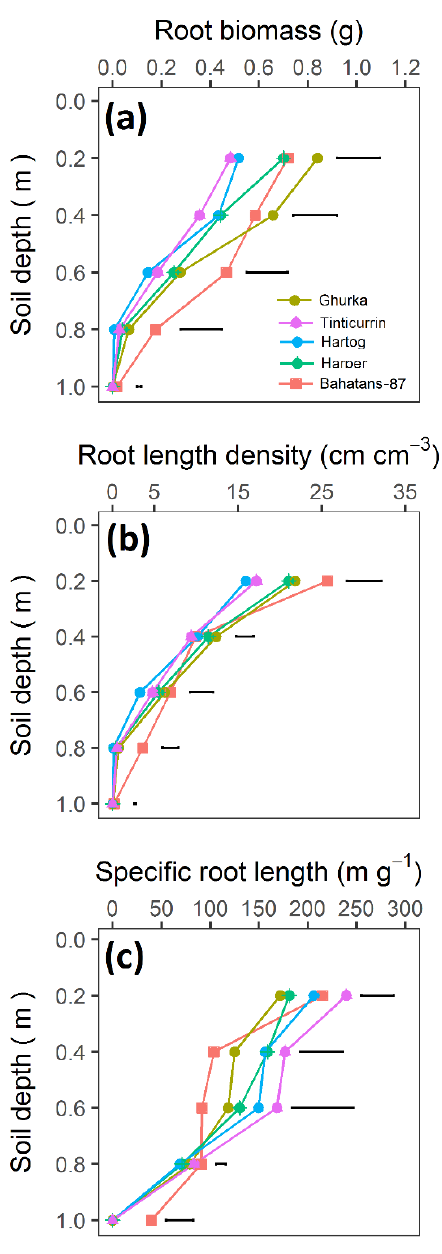
Figure 3. Destructively measured vertical profiles (0.2 m sections from the top to bottom of each rhizobox) of ( a ) root biomass, ( b ) root length density and ( c ) specific root length. The horizontal bars represent LSD at p < 0.05 for comparison between cultivars at each depth increment in the soil profile. Detailed supplementary data on the distribution down the soil profile of root biomass, RLD and SRL are available in Table